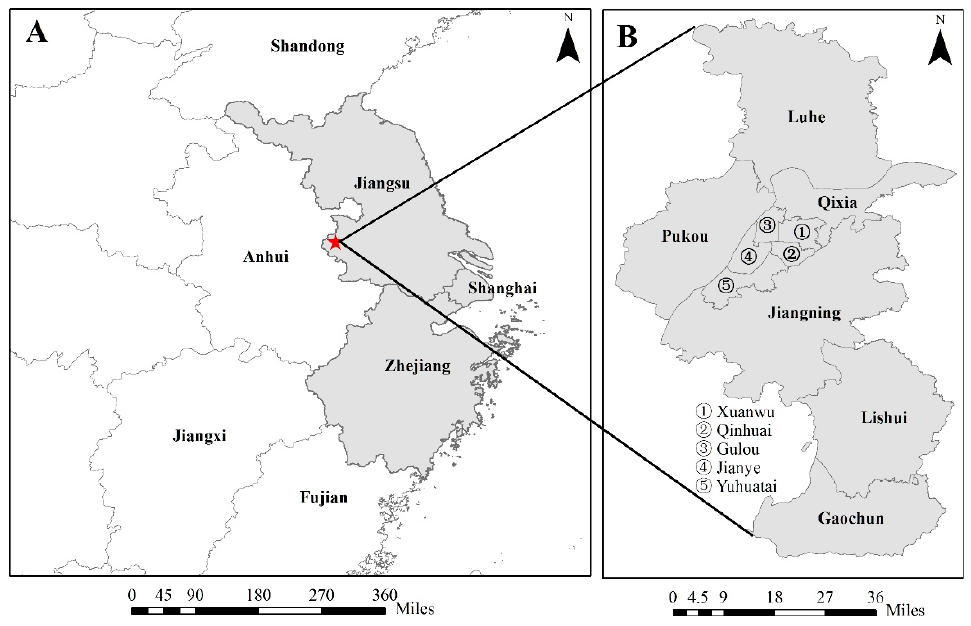
Figure 1. The location of the study area. ( A ) The Yangtze River Delta. ( B ) Nanjing.